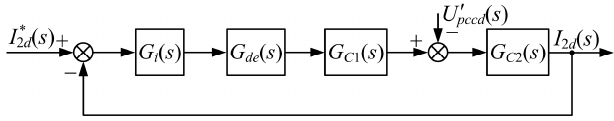
Figure 7. Grid current control block equivalent transformation.